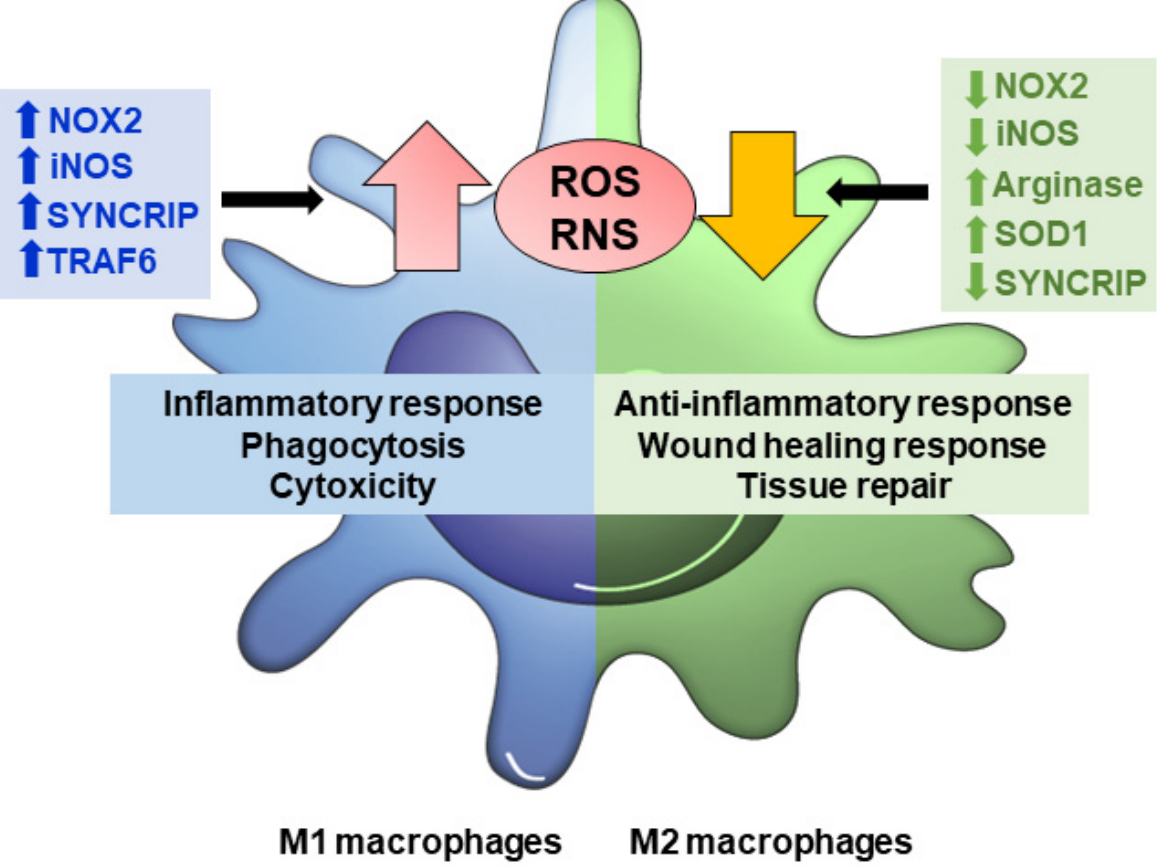
Figure 2. ROS/RNS production modulates macrophage polarization. In M1 macrophages, aug- mented levels of NOX2, iNOS, SYNCRIP (associated with NOX2 mRNA stability), and TRAF6 (in- volved in respiratory chain complex I stability) causes ROS/RNS production to increase, which trig- gers inflammatory response, phagocytosis, and cytotoxicity. M2 macrophages down-regulate NOX2, iNOS, SYNCRIP and/or up-regulate arginase and SOD1, counteract ROS and RNS, and favor anti-inflammatory response, would healing and tissue repair functions.